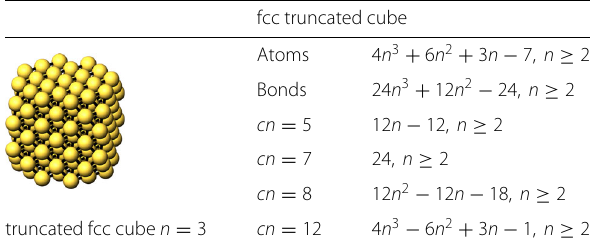
Table 8 Magic formulas for the fcc truncated